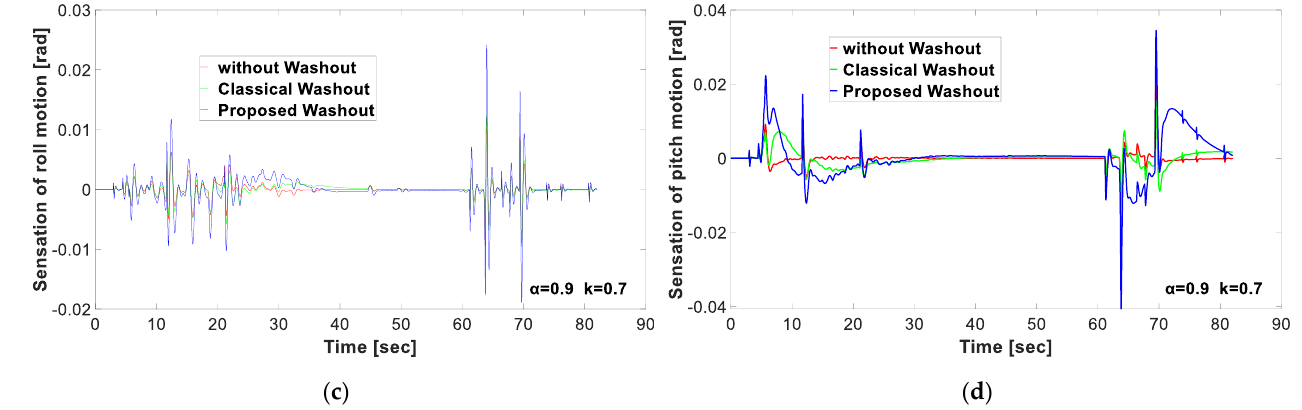
Figure 15. Motion sensation in the case of rapid acceleration ‒ deceleration driving. ( a ) Motion sensation of surge direction. ( b ) Motion sensation of sway direction. ( c ) Motion sensation of roll direction. ( d ) Motion sensation of pitch direction.